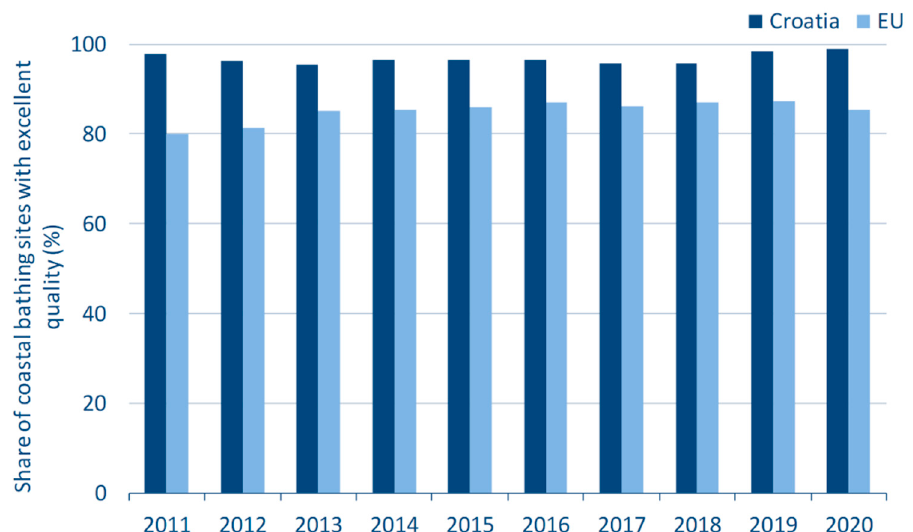
Figure 9. The share of coastal bathing waters with excellent water quality for HR and EU during the period 2011–2020.